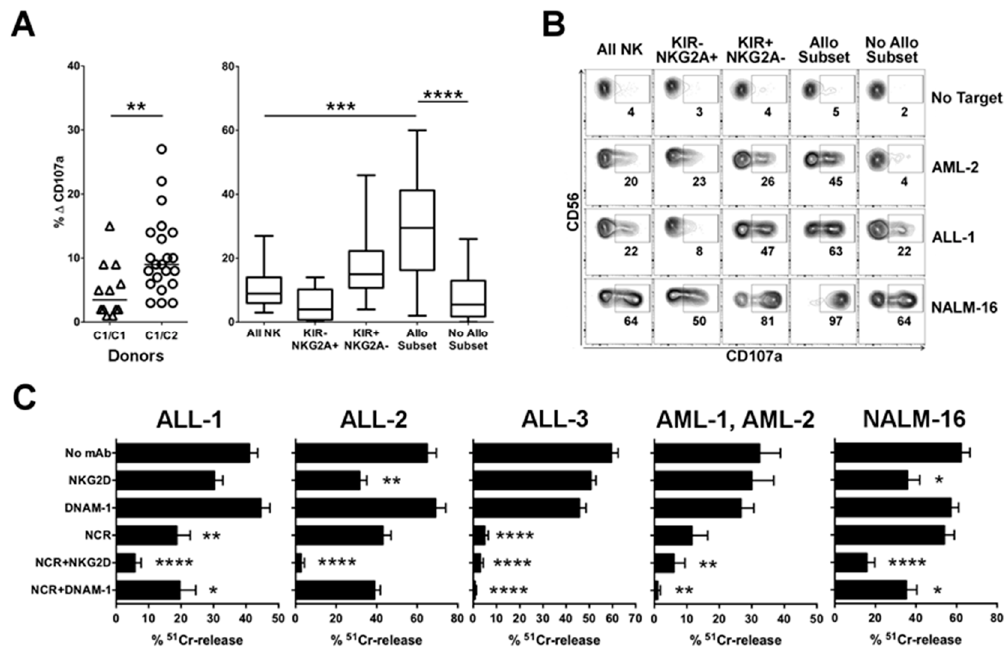
Figure 1. Relevance of alloreactivity and NCR for NK-mediated anti-leukemia activity. ( A ) NK cell specific degranulation activity ( ∆ CD107a) after stimulation with HLA-C1 / C1 primary ALLs (ALL-1 and ALL-3). E:T ratio 2:1. Left: comparison of HLA-C1 / C1 (C1 / C1) ( n = 12) and HLA-C1 / C2 (C1 / C2) ( n = 22) donors. ** p < 0.01 (Mann–Whitney test). Horizontal bars indicate the medians. Right: different NK cell subsets derived from the HLA-C1 / C2 donors are compared. The Allo Subset consists on sp2DL1 NK cells, No Allo Subset represents NK cells expressing iKIRs specific for ligands on target cells. *** p < 0.001, **** p < 0.0001 (Kruskal–Wallis test with Dunn’s post-test). Whisker lines represent the highest and lowest values; horizontal lines represent the medians. ( B ) Degranulation capacity of different NK cell subsets derived from a representative donor (donor of